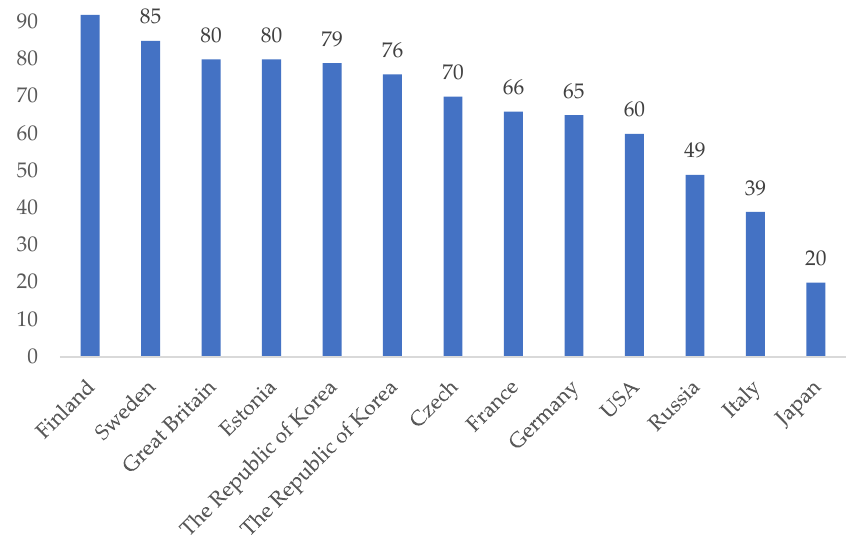
Figure 1. The use of digital technologies in the financial sector (as a percentage of the total number of organizations).